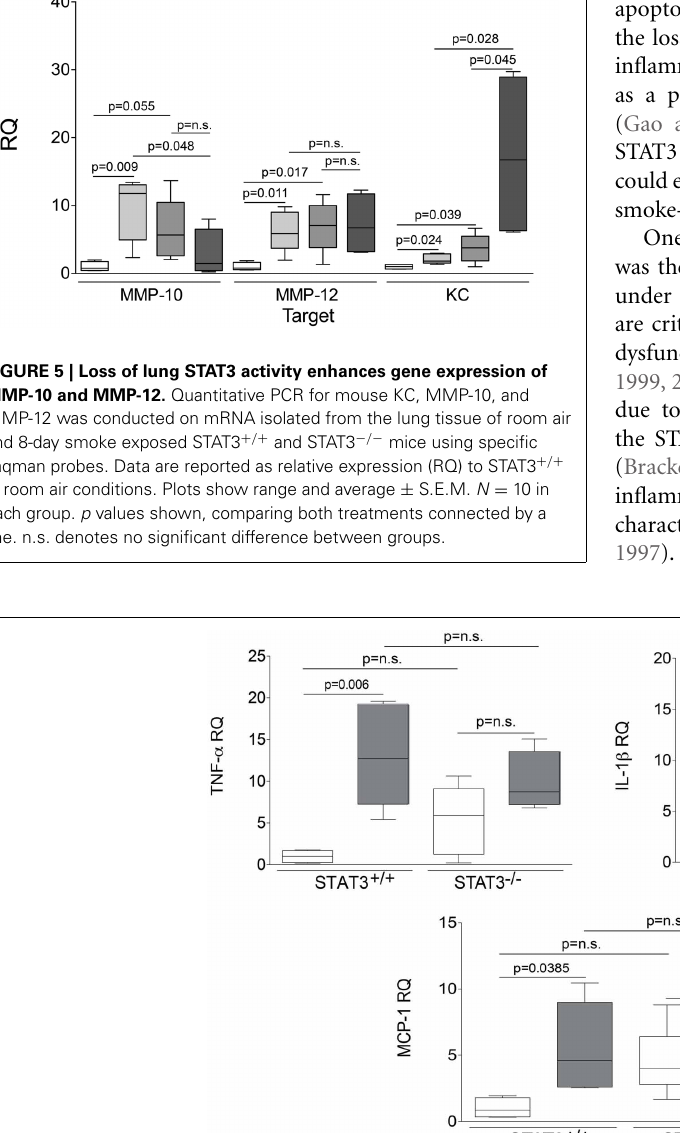
reported as relative expression (RQ) to STAT3 + / + in room air conditions. Plots show range and average ± S.E.M. N = 10 in each group. p values shown, comparing both treatments connected by a line. n.s. denotes no significant difference between